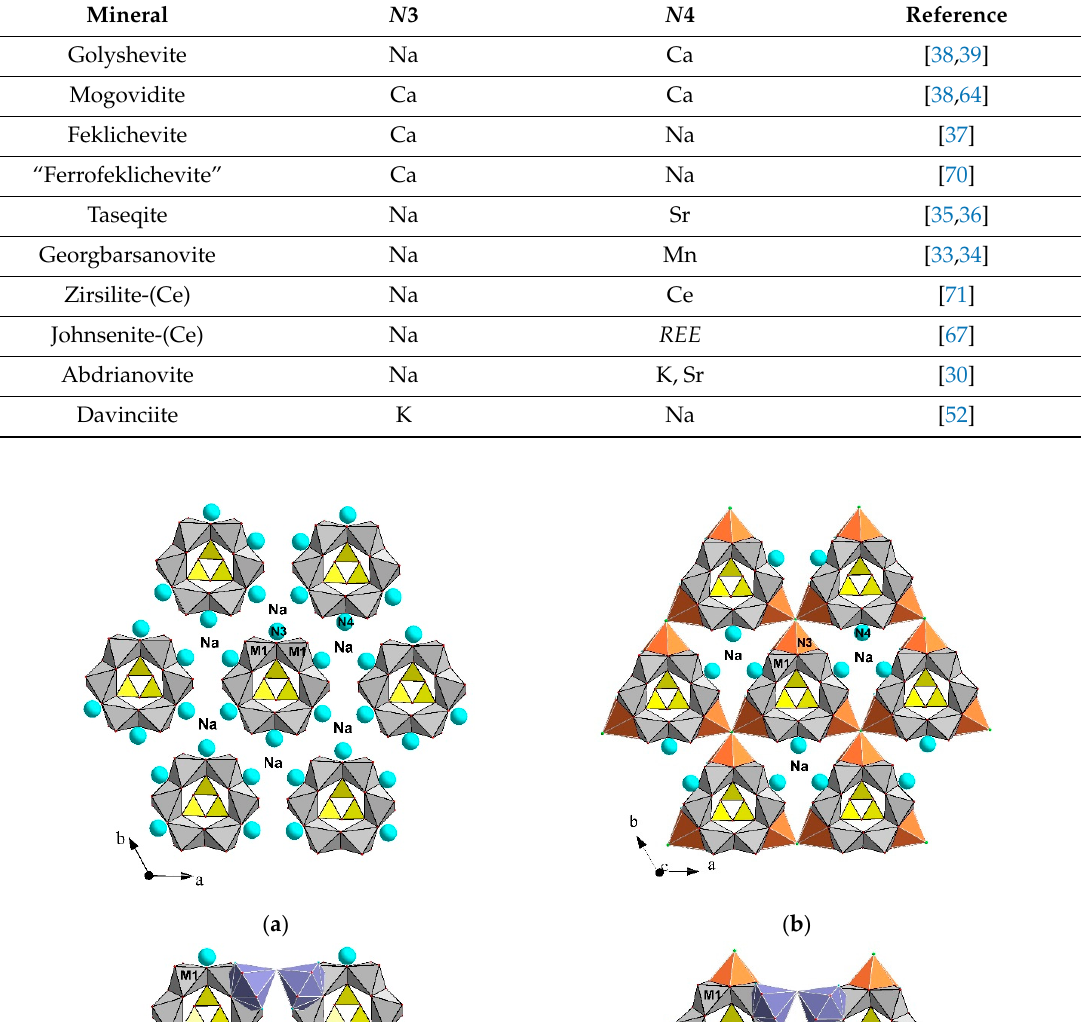
Table 3. Dominant components at the N 3 and N 4 sites of Na-depleted EGMs.